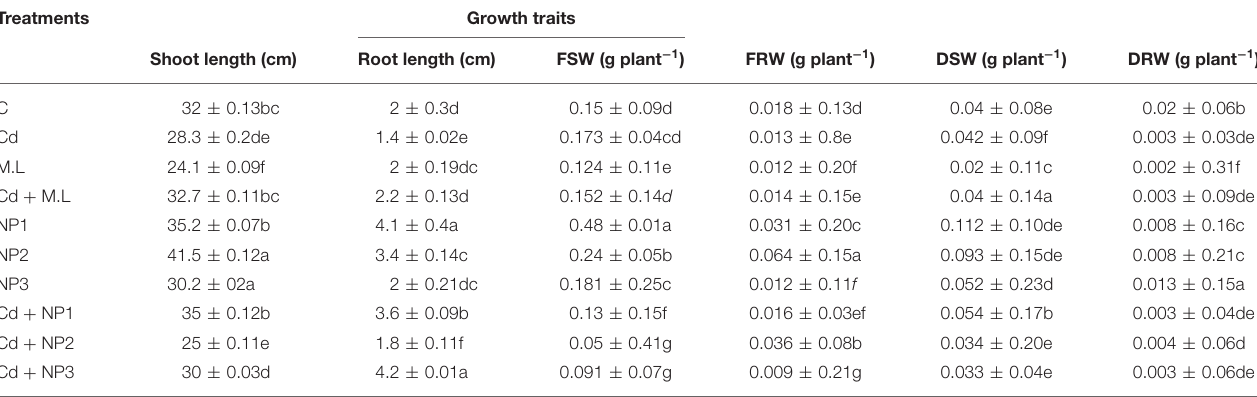
TABLE 1 | Effects of MZnO nanoparticles (NPs) on shoot length, root length, fresh shoot weight, fresh root weight, dry shoot weight, and dry root weight under Cd stress in linseed. Treatments Growth traits